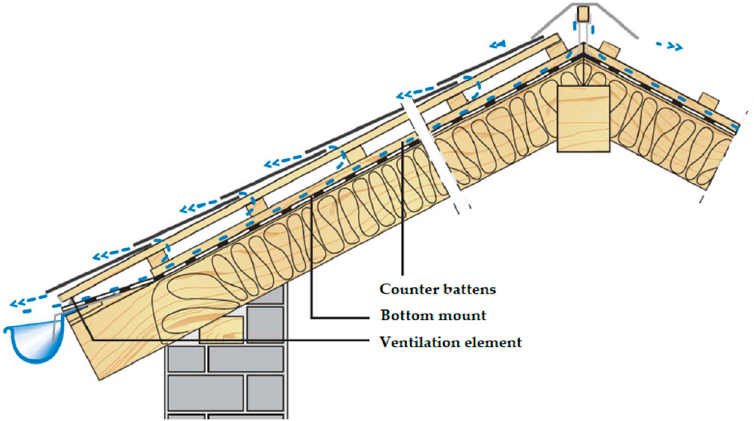
Figure 2. A scheme of mounting the PV roof tile on a roof [26].